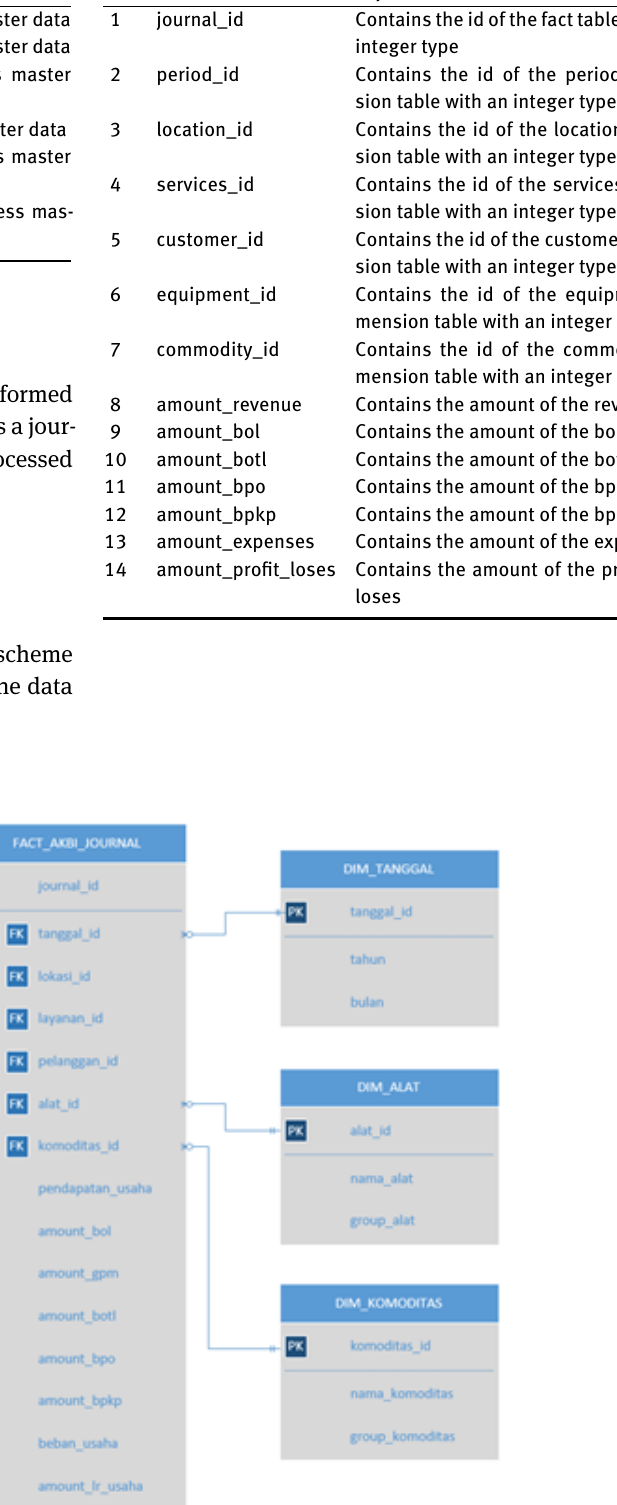
Figure 4: Data Warehouse